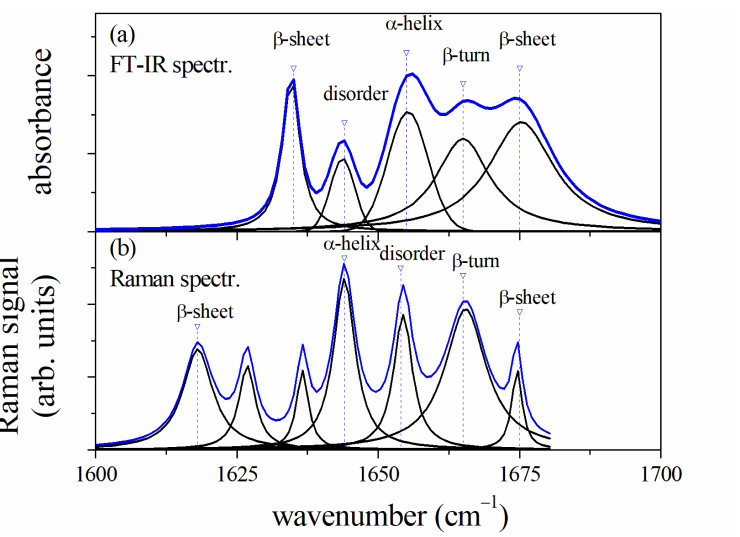
Figure 5. Comparison of µ -FTIR ( a ) and µ -RS Amide I spectral region ( b ) of GCF before OTM (T0). The position of mode components and assignments are reported for the two